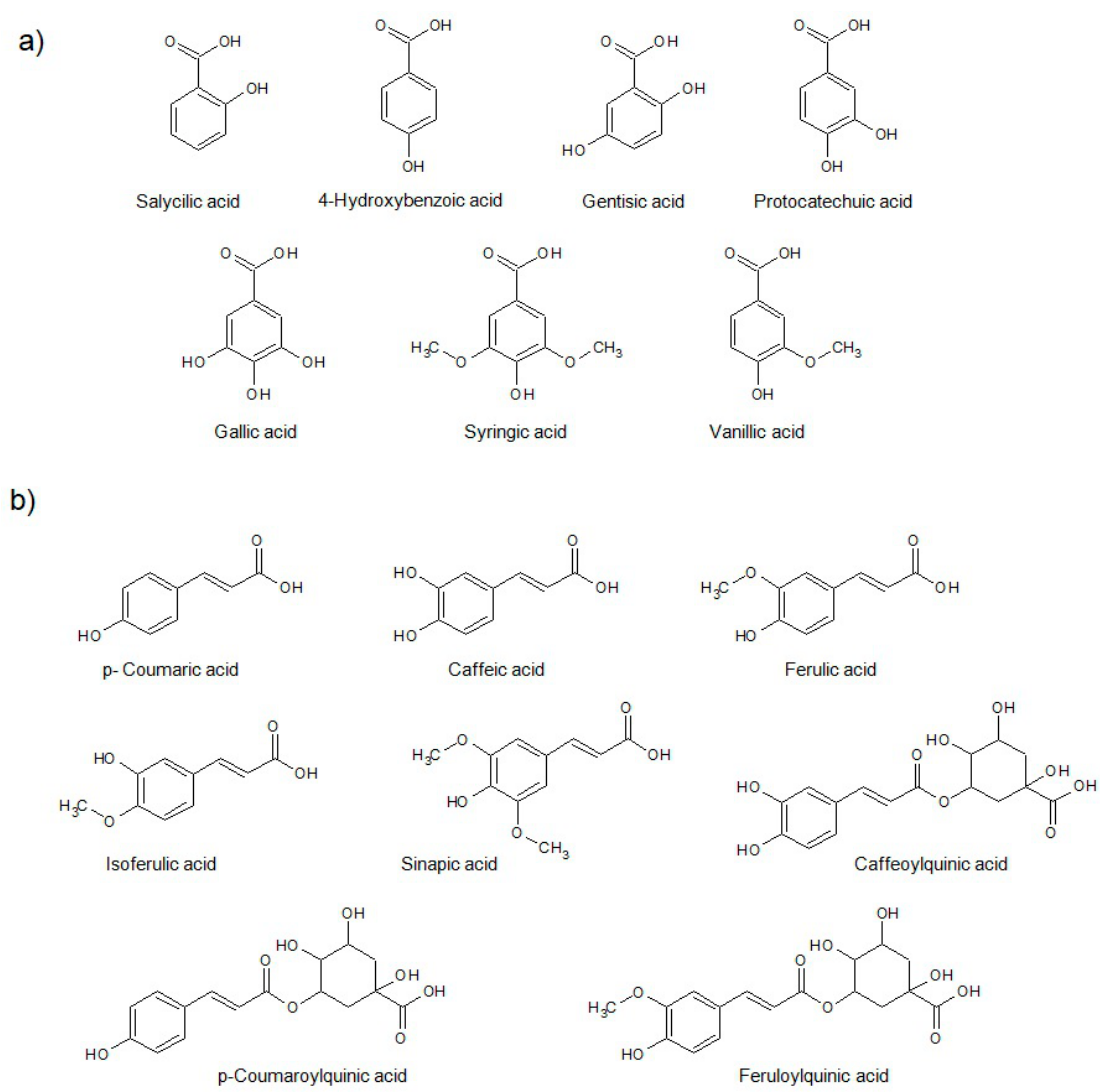
Figure 1. Hydroxybenzoic ( a ) and hydroxycinnamic acids ( b ) commonly found in rice.